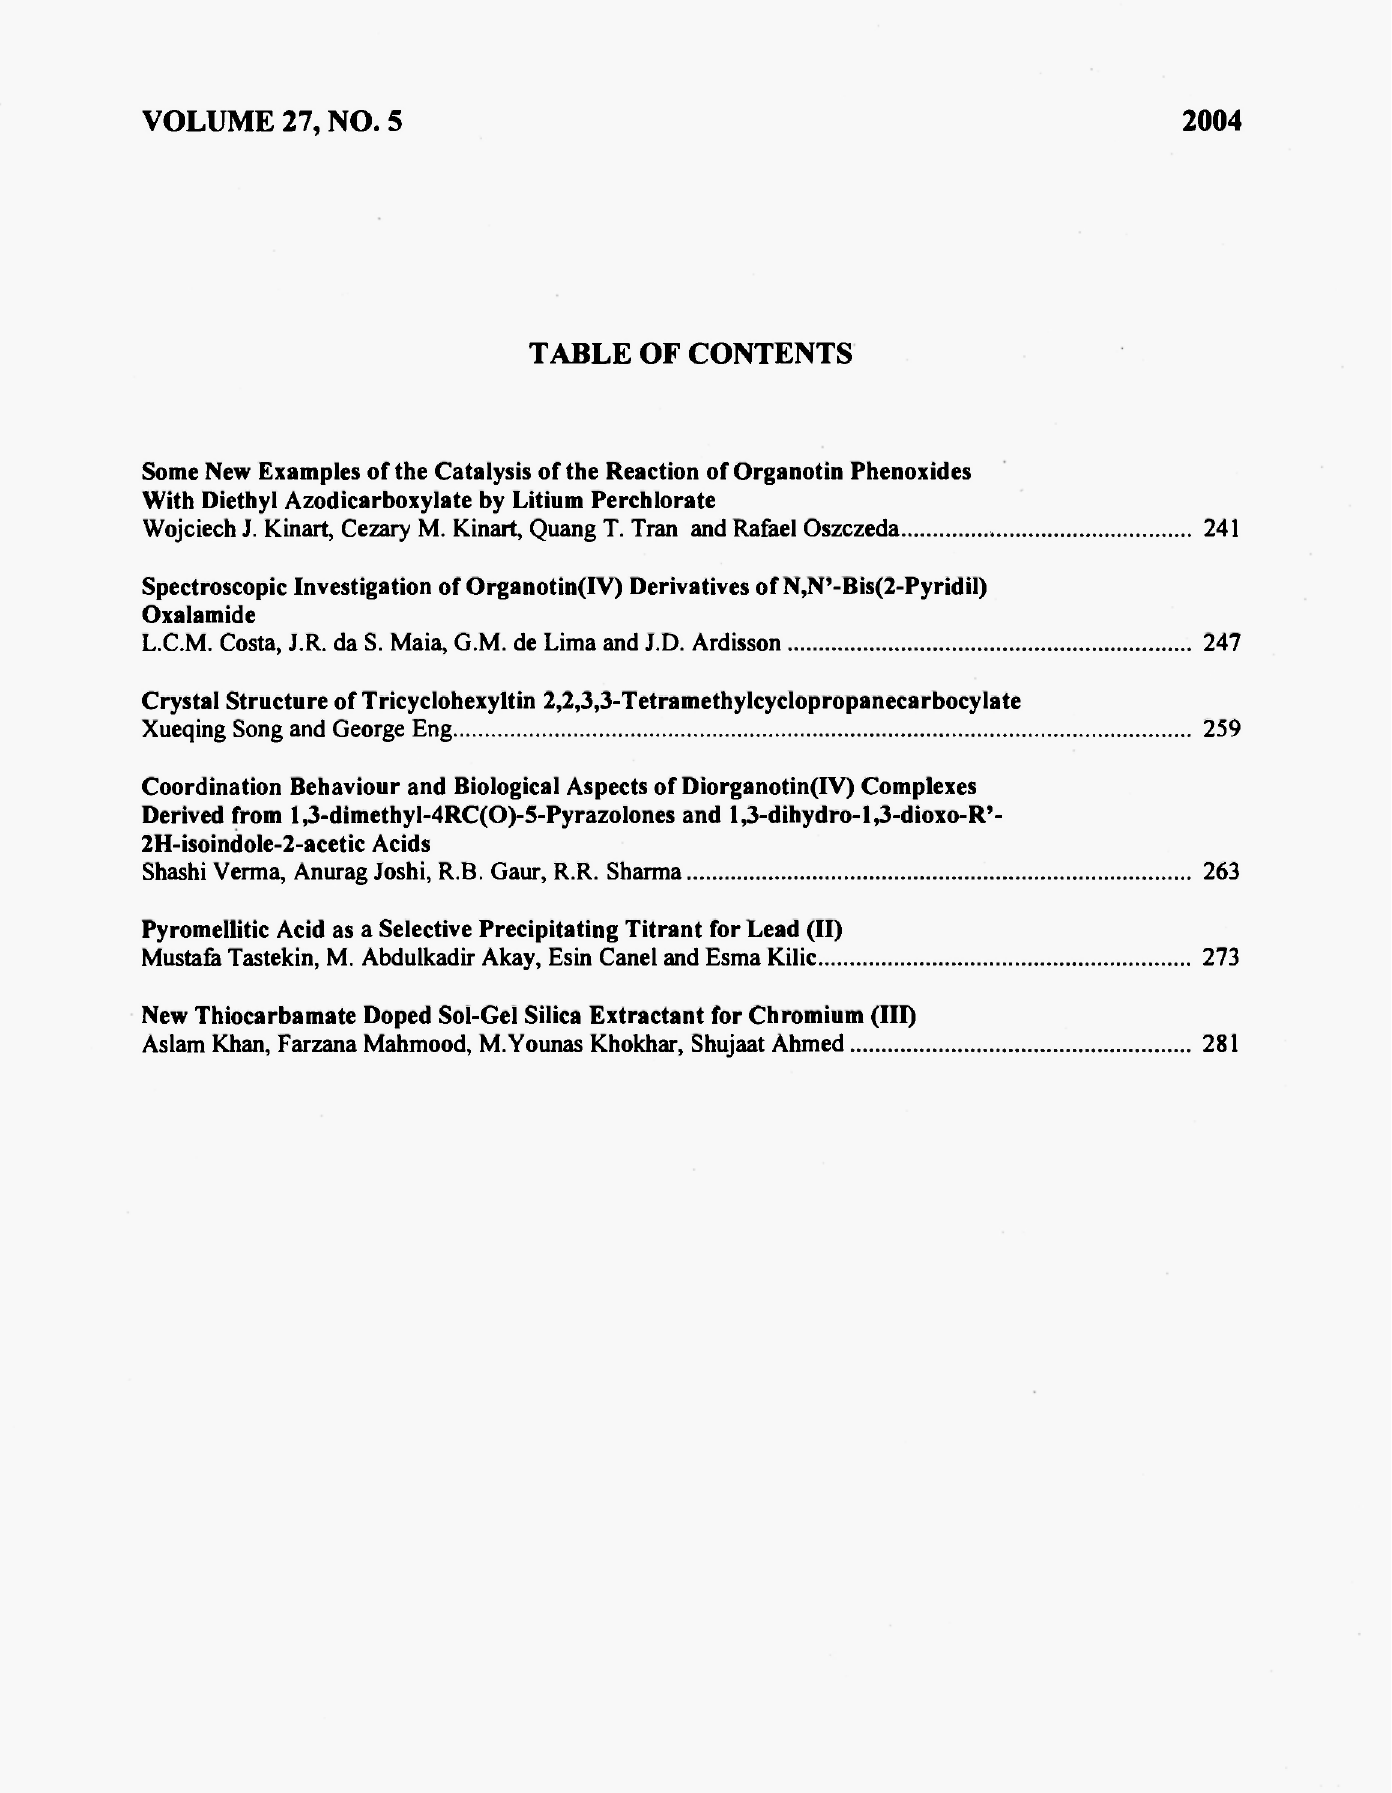
Some New Examples of the Catalysis of the Reaction of Organotin Phenoxides With Diethyl Azodicarboxylate by Litium